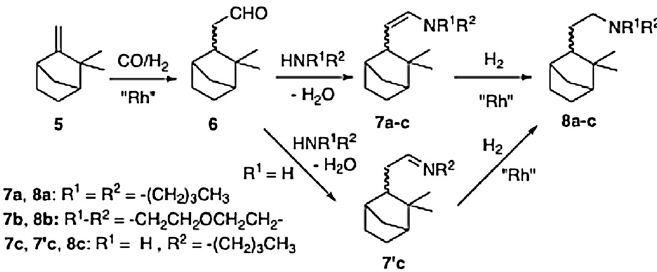
Figure 11. Hydroaminomethylation of camphene ( 5 ). Reprinted from [74] with permission from Elsevier.